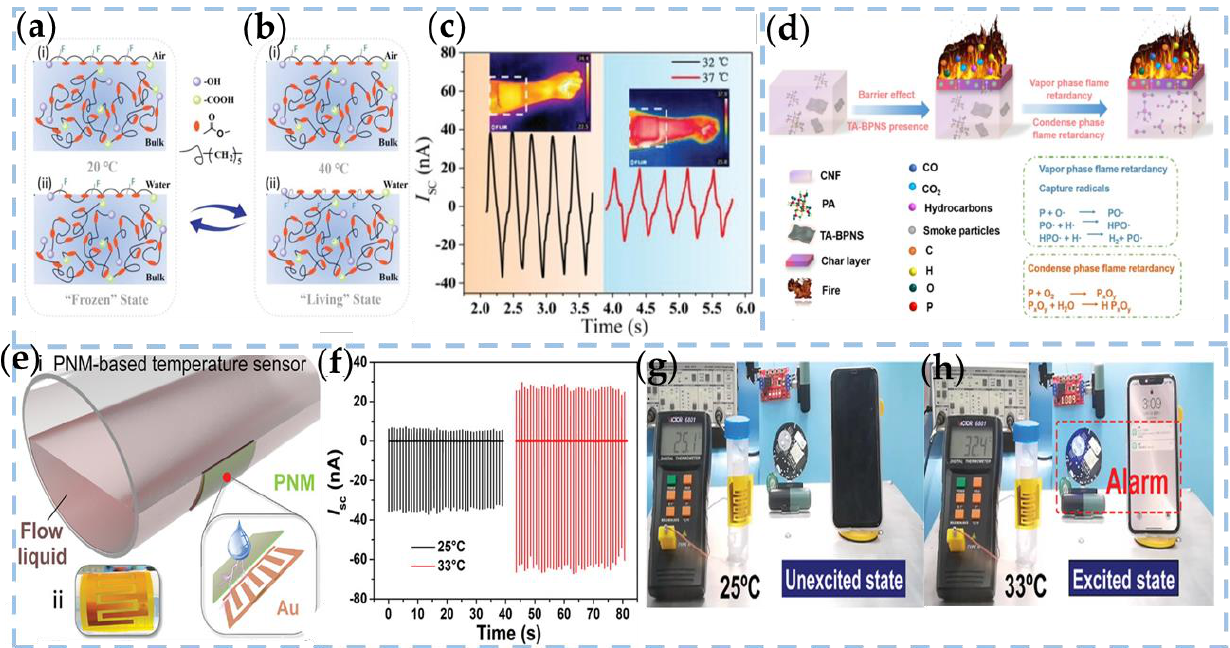
Figure 6. Conformation of PCL chains at (i) air–polymer interface and (ii) water–polymer interface at ( a ) 20 °C and ( b ) 40 °C. ( c ) Wearable liquid–solid TENG is used for detecting human body temperature [77]. Copyright 2021, WILEY-VCH. ( d ) Flame-retardant mechanism illustration of CNF-BP-PA film [78]. Copyright 2022, ELSEVIER SCIENCE SA. ( e ) Schematic diagram of the PNM-based temperature sensor with designed structure, ( f ) detected short-circuit current ( I SC ) when droplets impact onto the surface of PNM under 25 and 33 °C. ( g , h ) The photographs show the “unexcited” and “excited” state of the warning sensor under 25 and 33 °C, respectively [79]. Copyright 2022, WILEY-VCH VERLAG GMBH.